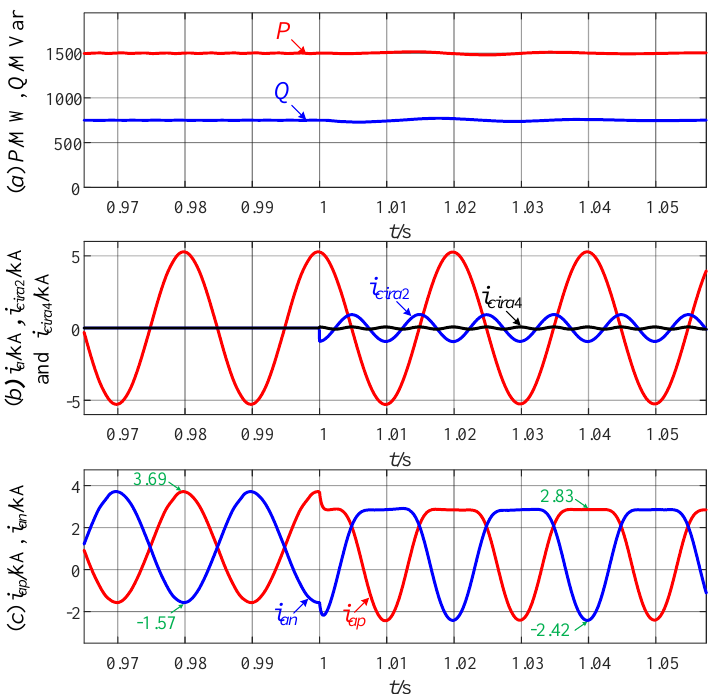
Figure 8. Simulation waveforms of the MMC operating in the inverter mode before and after using the proposed MCCIC strategy. Table 2. Comparisons between the theoretical values and the simulation results of the arm currents.